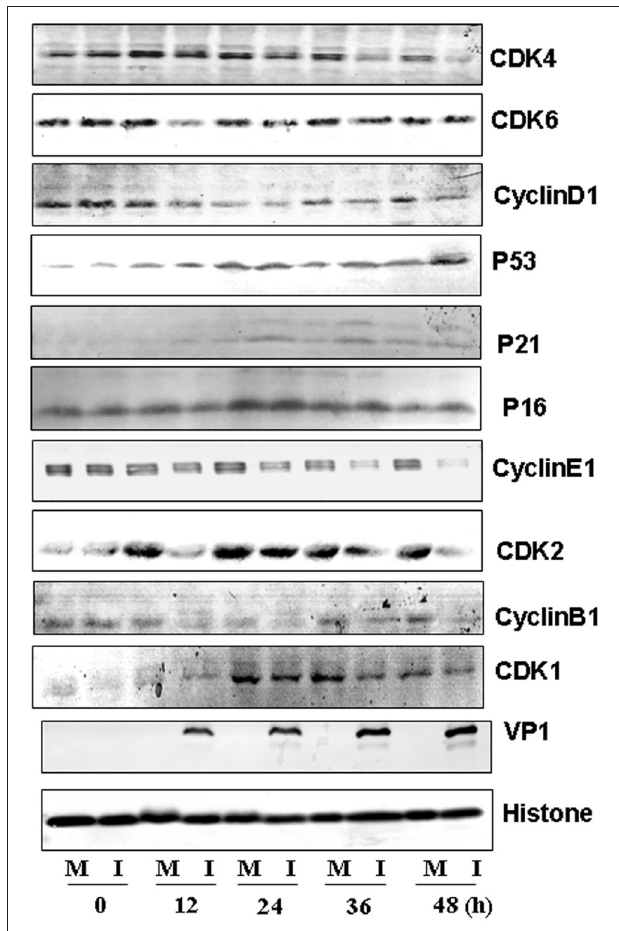
FIGURE 7 | Western blot analysis of cell-cycle related proteins . RD cells, mock-infected (M) or infected with CVA6 (I) at an MOI of 1, were collected at 0, 12, 24, 36, and 48h. The expression of CDK4, CDK6, cyclinD1, P53, P21, P16, cyclinE1, CDK2, cyclinB1, CDK1, and VP1 proteins was analyzed. Histone is the loading control. The results were representative of three independent